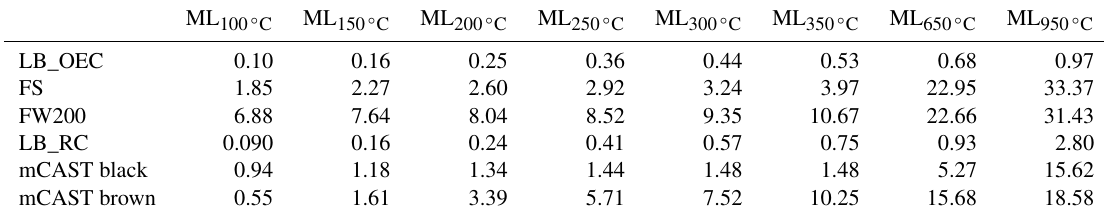
Table A3. Relative mass loss as determined by TGA analysis in a pure N 2 atmosphere. Mass loss (ML) for soot samples is expressed as cumulative, relative weight loss at a given reference temperature and is given as percentage mass loss from initial weight. Reported values indicate mean values of two TGA experiments performed for a given soot type.